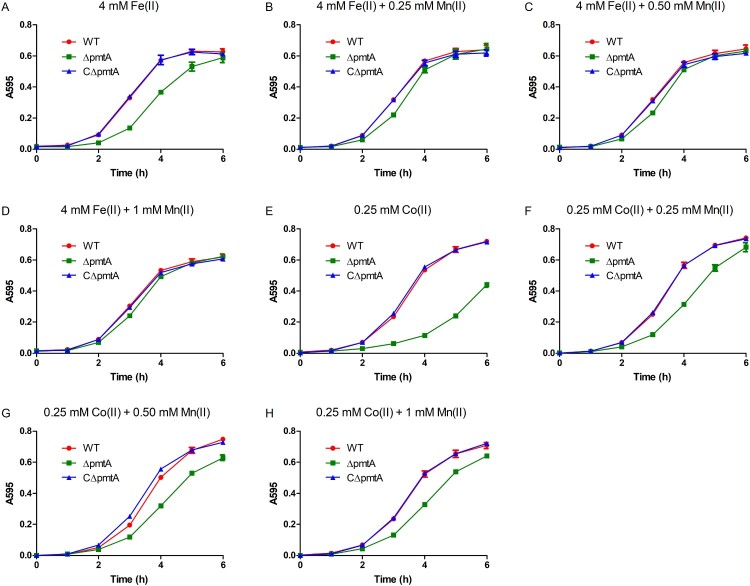
Mn(II) supplementation rescues growth defect of ΔpmtA. (A–D) The WT, ΔpmtA, and CΔpmtA strains were grown in the presence of 4 mM Fe(II) alone (A) or 4 mM Fe(II) with 0.25 mM (B), 0.50 mM (C), or 1 mM Mn(II) (D). (E-H) Growth curves in the presence of 0.25 mM Co(II) alone (E) or 0.25 mM Co(II) with 0.25 mM (F), 0.50 mM (G), or 1 mM Mn(II) (H). Graphs data are mean values ± SD from three wells.